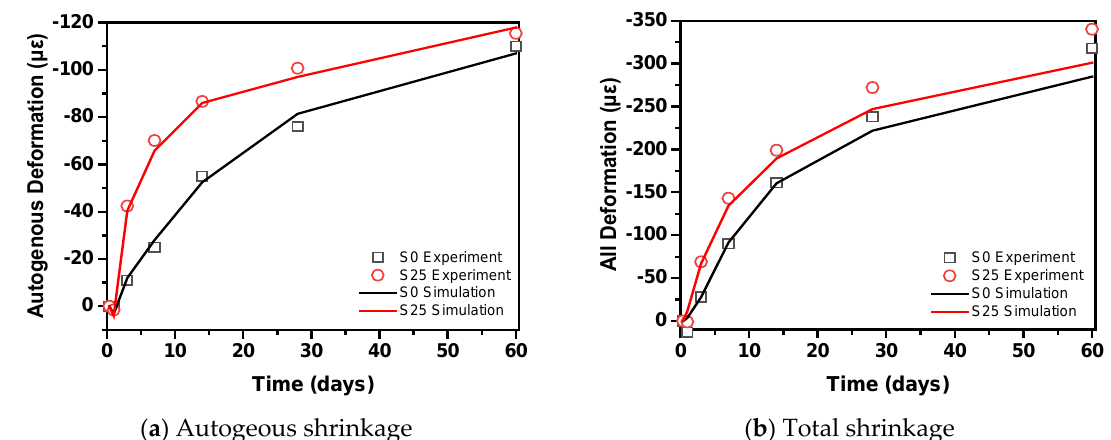
Figure 18. Comparison of experimental and calculated results of shrinkage of concrete.